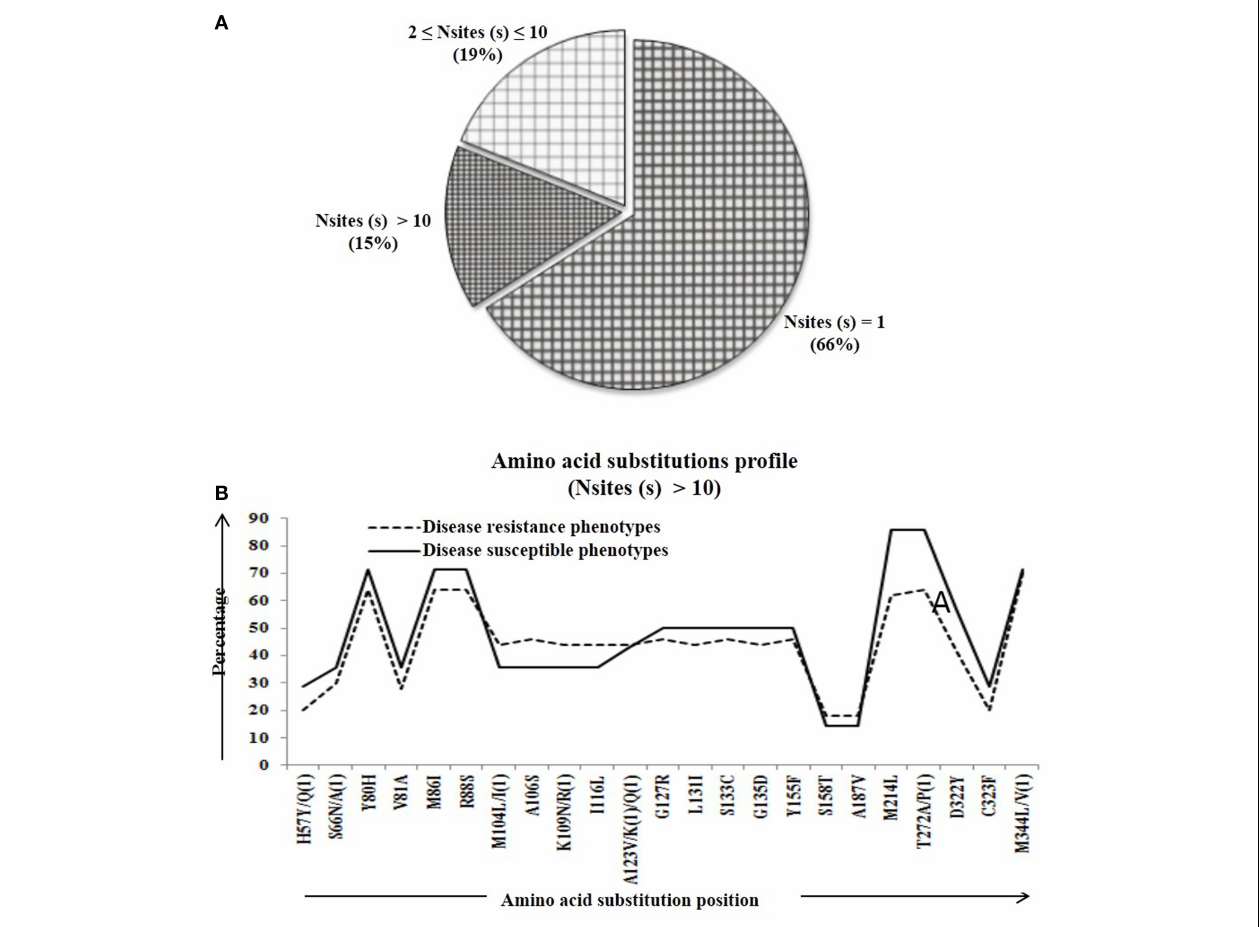
FIGURE 6 | The number of amino acid substitutions in the predicted 64 Pi54 protein. (A) Distribution of amino acid substitutions across 64 predicted proteins. (B) Substitutional profile of amino acids of disease resistant and susceptible